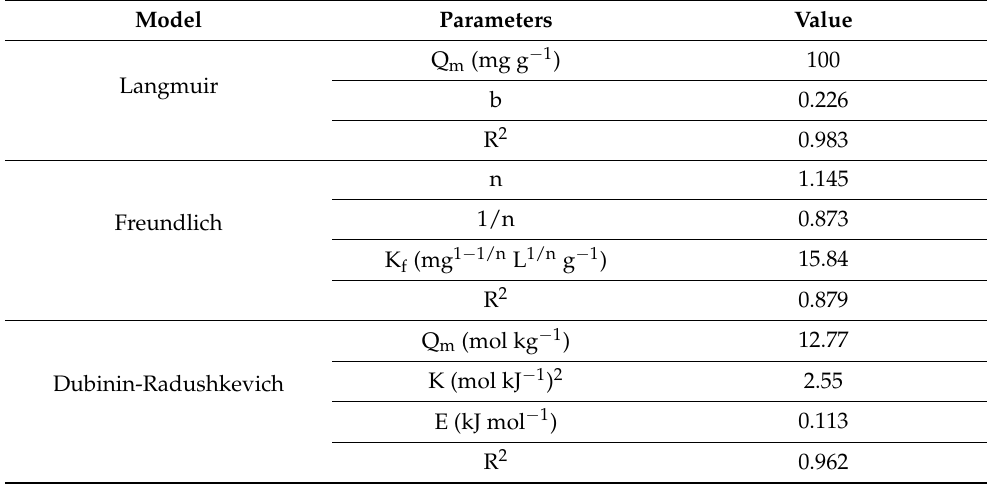
Table 3. Sorption isotherm parameters for the removal of IV2R onto P. capillacea nanoparticles.